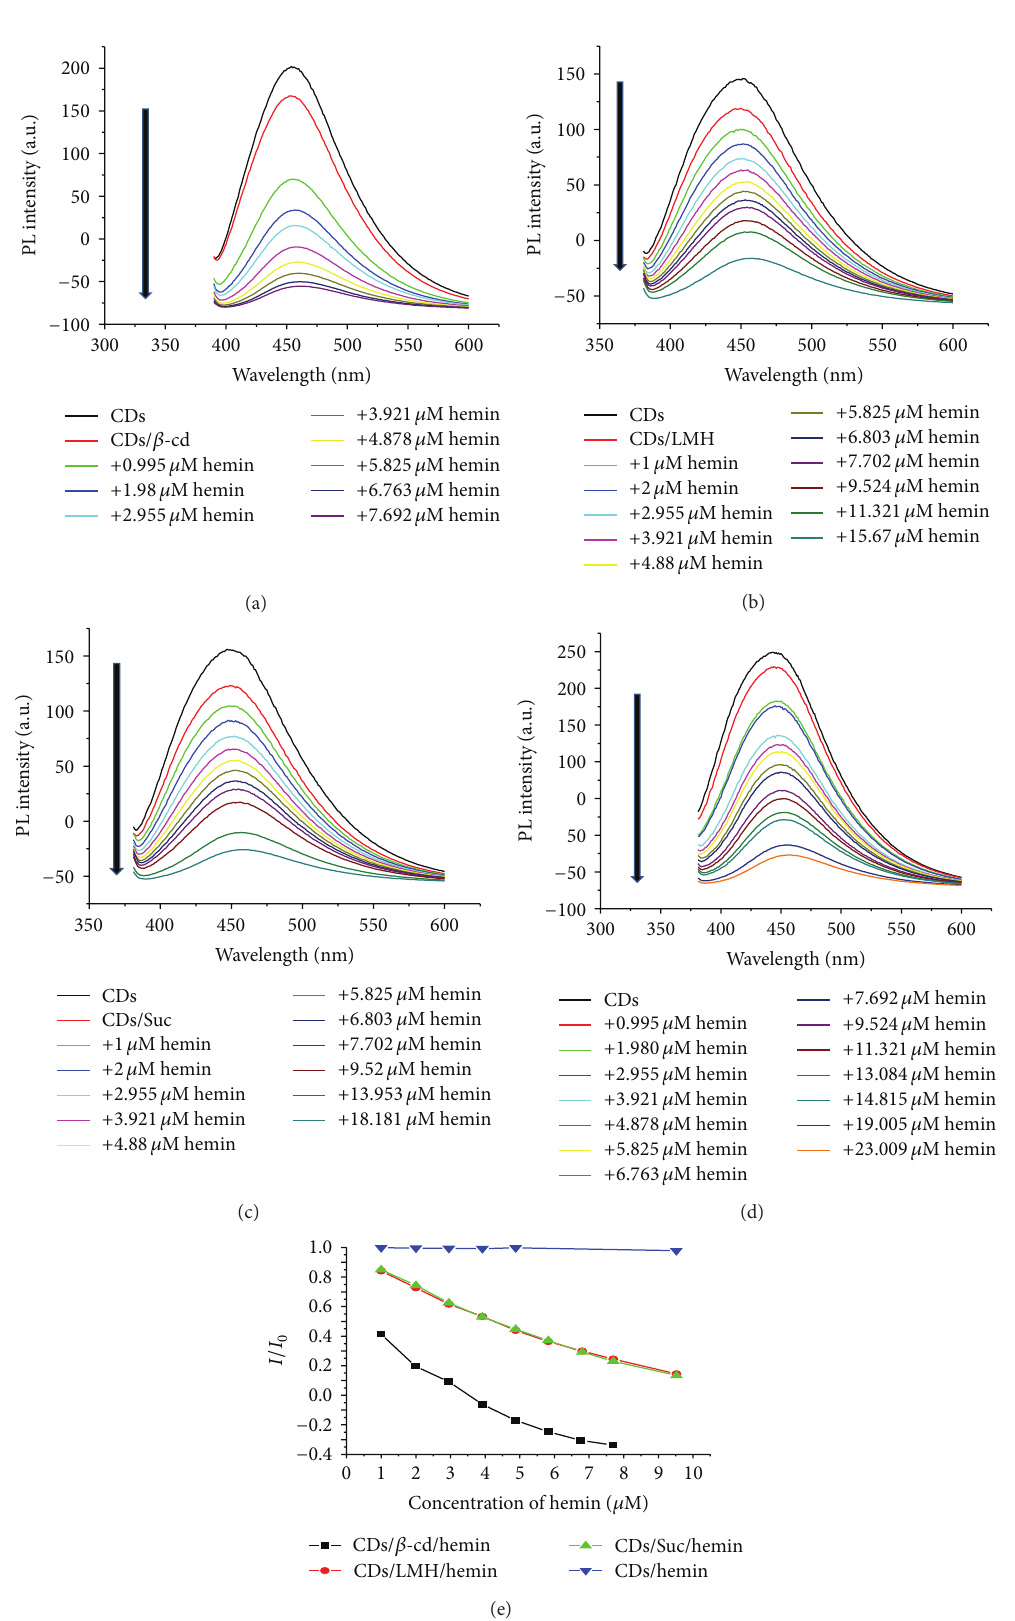
Figure 3: Photoluminescence emission spectra of (a) CDs/ 𝛽 -cd, (b) CDs/LHM, (c) CDs/Suc, and (d) bare CDs at different concentrations of hemin. (e) Plots of the donor fluorescence intensity against the concentration of